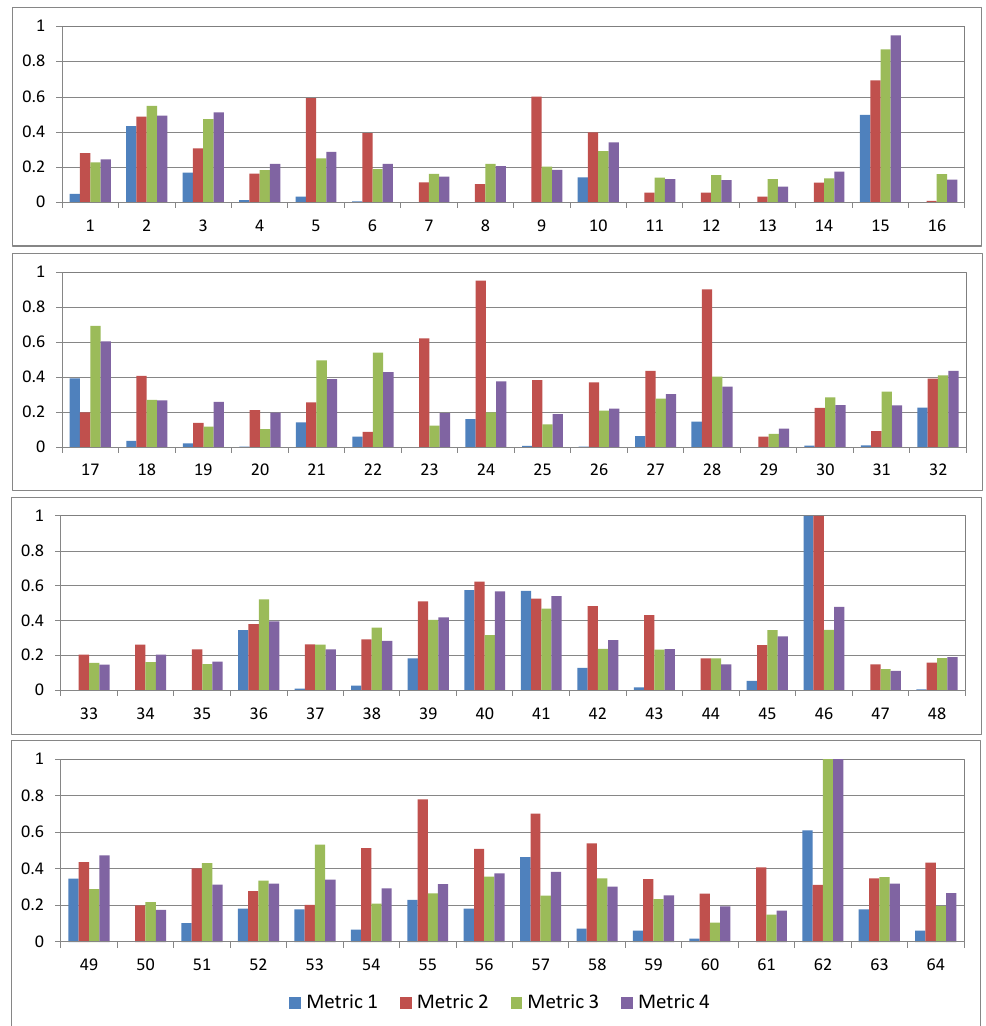
Figure 6. Normalized IP metrics for the 64 landfalling TCs found in the WRF model simulations. TCs are given chronologically. These normalized values were obtained by dividing the dimensional IP metrics by the maximum values given in Table 5. The dates of each TC may be found in Table